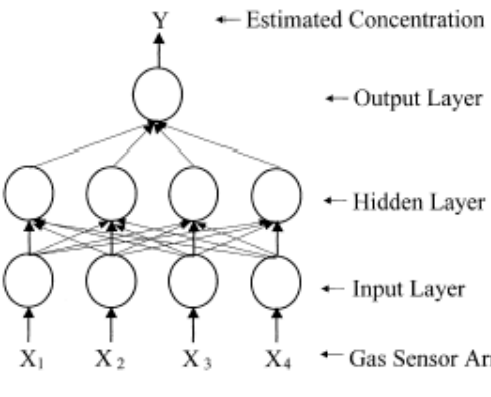
Figure 5. ANN architecture of e-nose. The first layer is called as gas sensor layer; the second, hidden layer; the last, output concentration layer. Signals are transferred from layer to layer and their values are decided by both the transfer function used by each neuron and the connection weights between two different